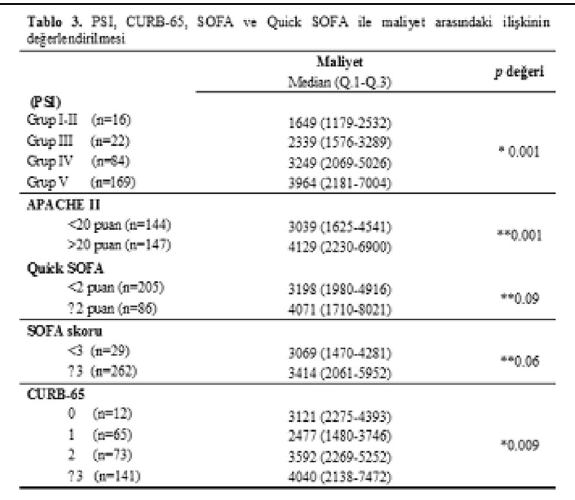
Table 1 (abstract 0283).